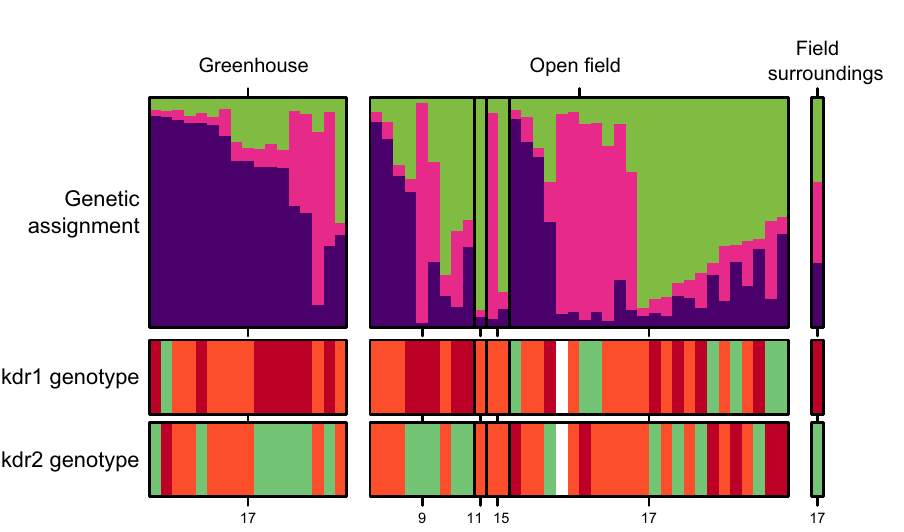
Figure 3. Genetic assignment (Bayesian assignment to K = 3 clusters, purple, pink and green bars) and kdr genotype at the loci L1 and L2 (green for SS, orange for RS and red for RR) for MED individuals sampled in greenhouse, open field and field surroundings. Missing data are indicated by white bars. Numbers on the X-axis (9, 11, 15 and 17) correspond to sampling sites as referred to in Table